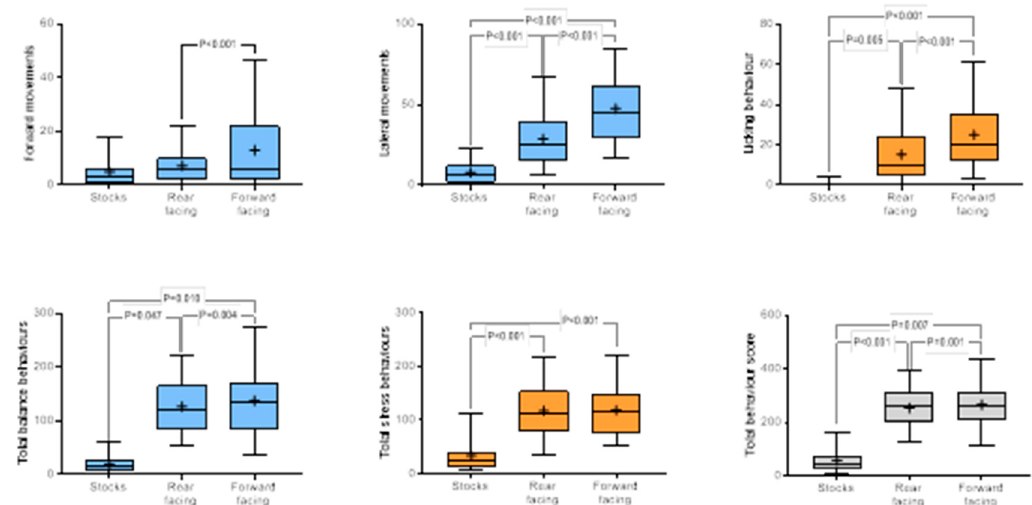
Figure 5. Effect of direction of travel (stocks, forward or rear facing) on key behavioural characteristics. Results are shown as mean ( ₊ ) and median (horizontal line), quartile (box) and 95% confidence interval (whiskers), with significant differences between groups indicated. Balance-related behaviours are blue, stress-related behaviours are orange, total behaviours are shown in grey.